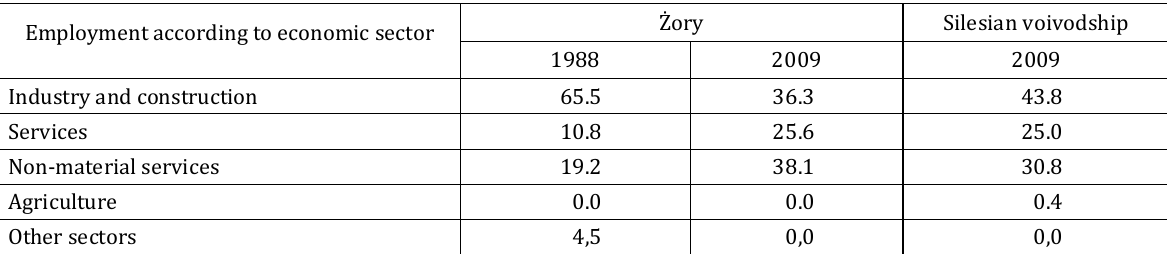
Table 2. Labour market employment in % (after Rocznik statystyczny województwa śląskiego, 1989-2009) Employment according to economic sector